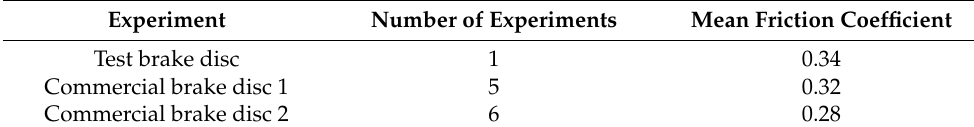
Table 5. Friction coefficients of the three brake discs in the dynamic tests at an overload landing energy.